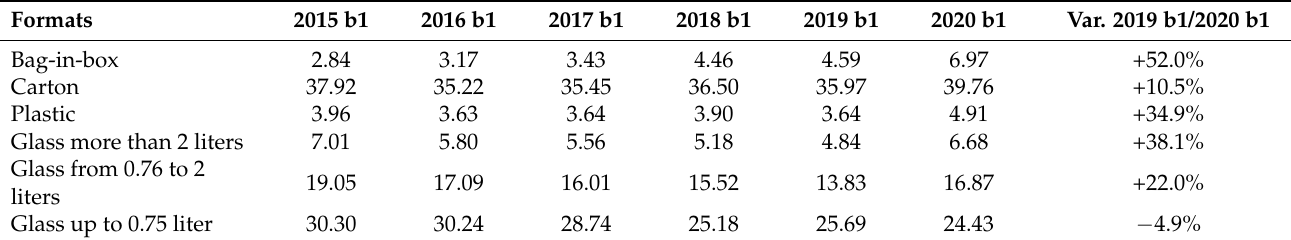
Table 3. Sales in value of wine in the 0–3 EUR/liter range by format (millions of